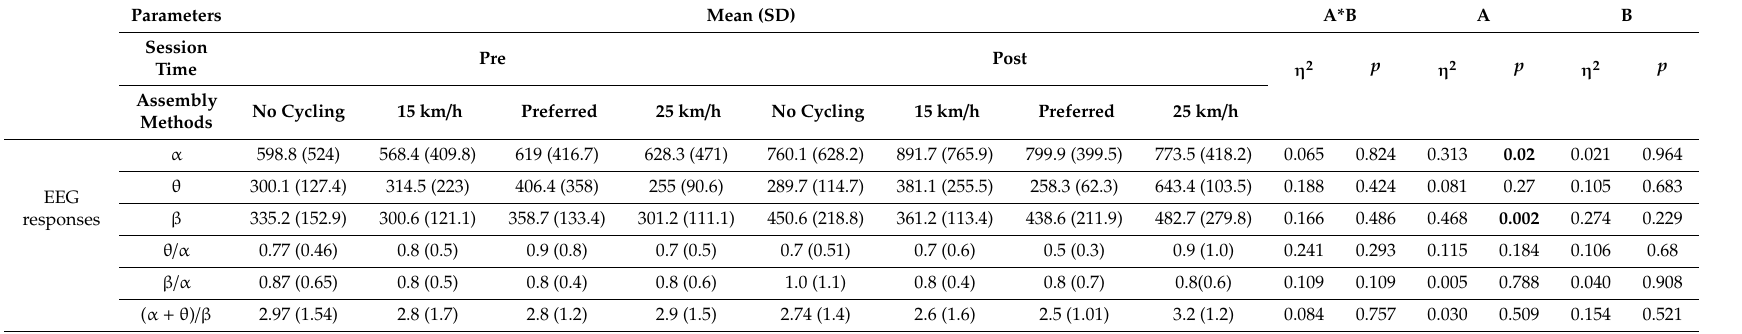
Table 3. Mean (standard deviation) values of power of EEG before and after assembly task with cycling conditions.